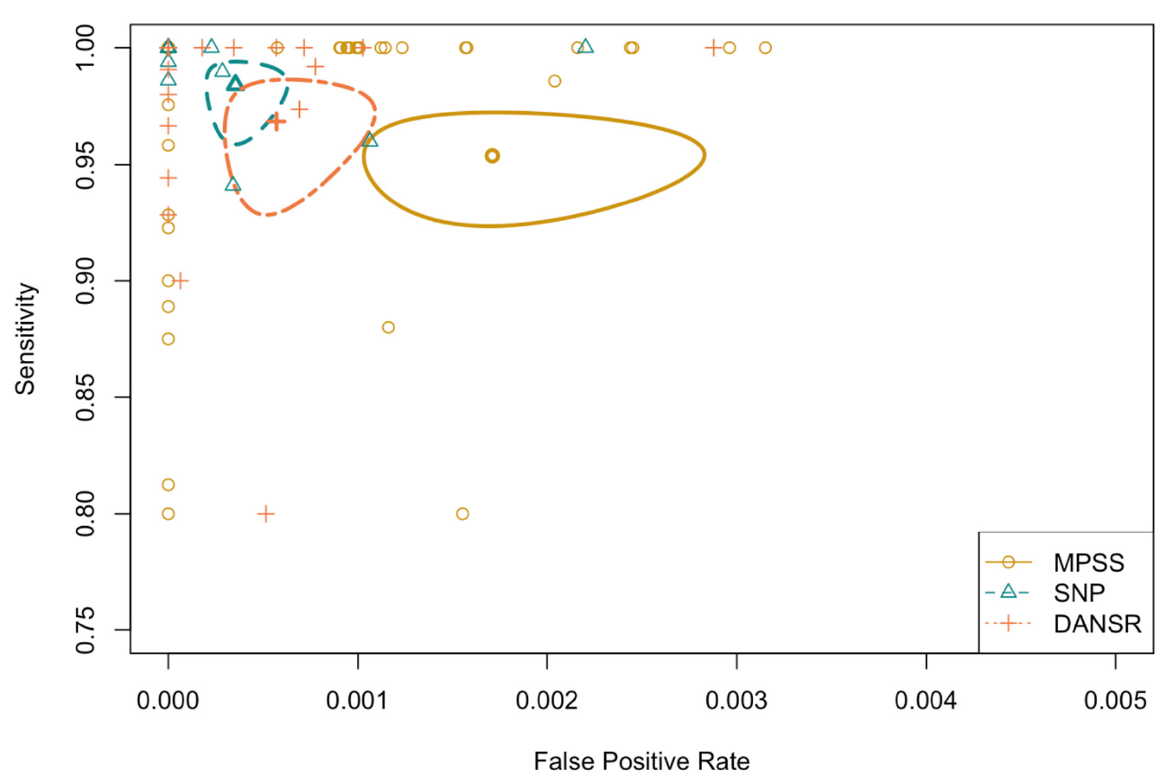
Figure 2. Summary Receiver Operating Curve for NIPT validation studies for common trisomies comparing MPSS, DANSR, and SNP.